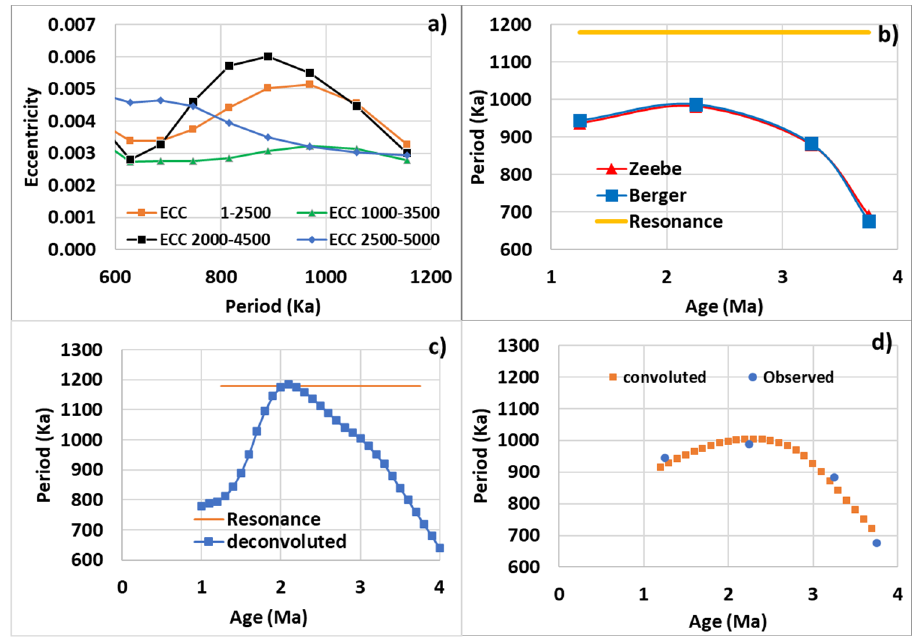
Figure 7. Variations in the period of eccentricity in the vicinity of 1000 Ka calculated from Berger and Loutre [47]—( a ) Fourier transform of eccentricity variations over 2.5 Ma time intervals—( b ) Periods vs. time observed at the maximums of the Fourier transforms in ( a ). The same values calculated from Zeebe and Lourens [49] are also represented—( c ) Deconvoluted curve of the period vs. time represented in b)—( d ) Comparison of the moving average over 2.5 Ma of the deconvoluted curve in ( c ) and the period vs. time in ( b ).